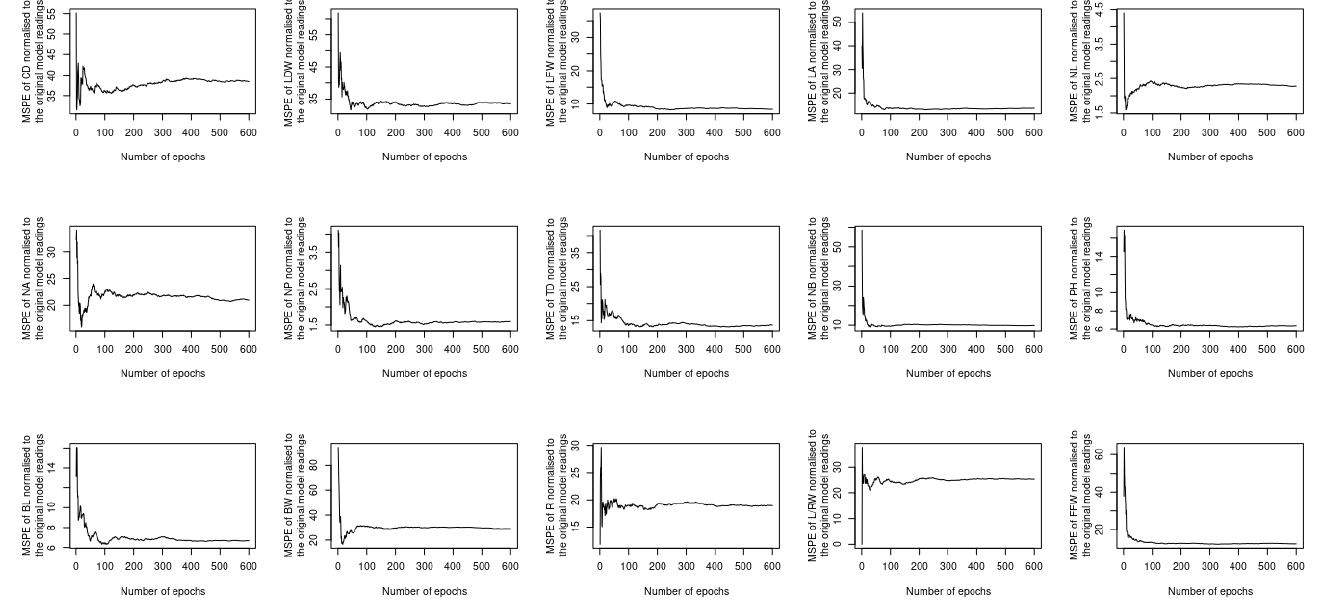
Figure 14. MSPE of the newly constructed models normalized to the original model .